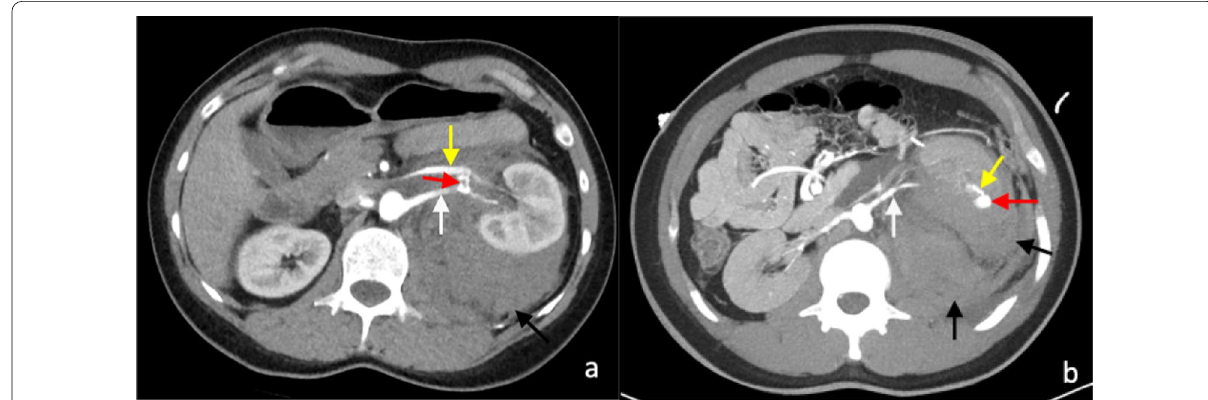
Fig. 12 Post-contrast arterial phase axial CT images of vascular complications following non-targeted ultrasound-guided 14-gauge core biopsies of the left kidney in two patients. a Arteriovenous fistula. There is a fistulous connection (red arrow) between the left renal artery (white arrow) and the left renal vein (yellow) with associated early arterialised enhancement of the proximal left renal vein, medial to the arteriovenous fistula. There is an associated retroperitoneal haematoma (black arrow). b Arterial pseudoaneurysm. A small pseudoaneurysm (red arrow) arising from a segmental branch of the left renal artery (yellow arrow) is visualised as an adjacent small focus of rounded arterial enhancement (red arrow). The main left renal artery is also visible (white arrow). There is an associated left perinephric and retroperitoneal haematoma (black